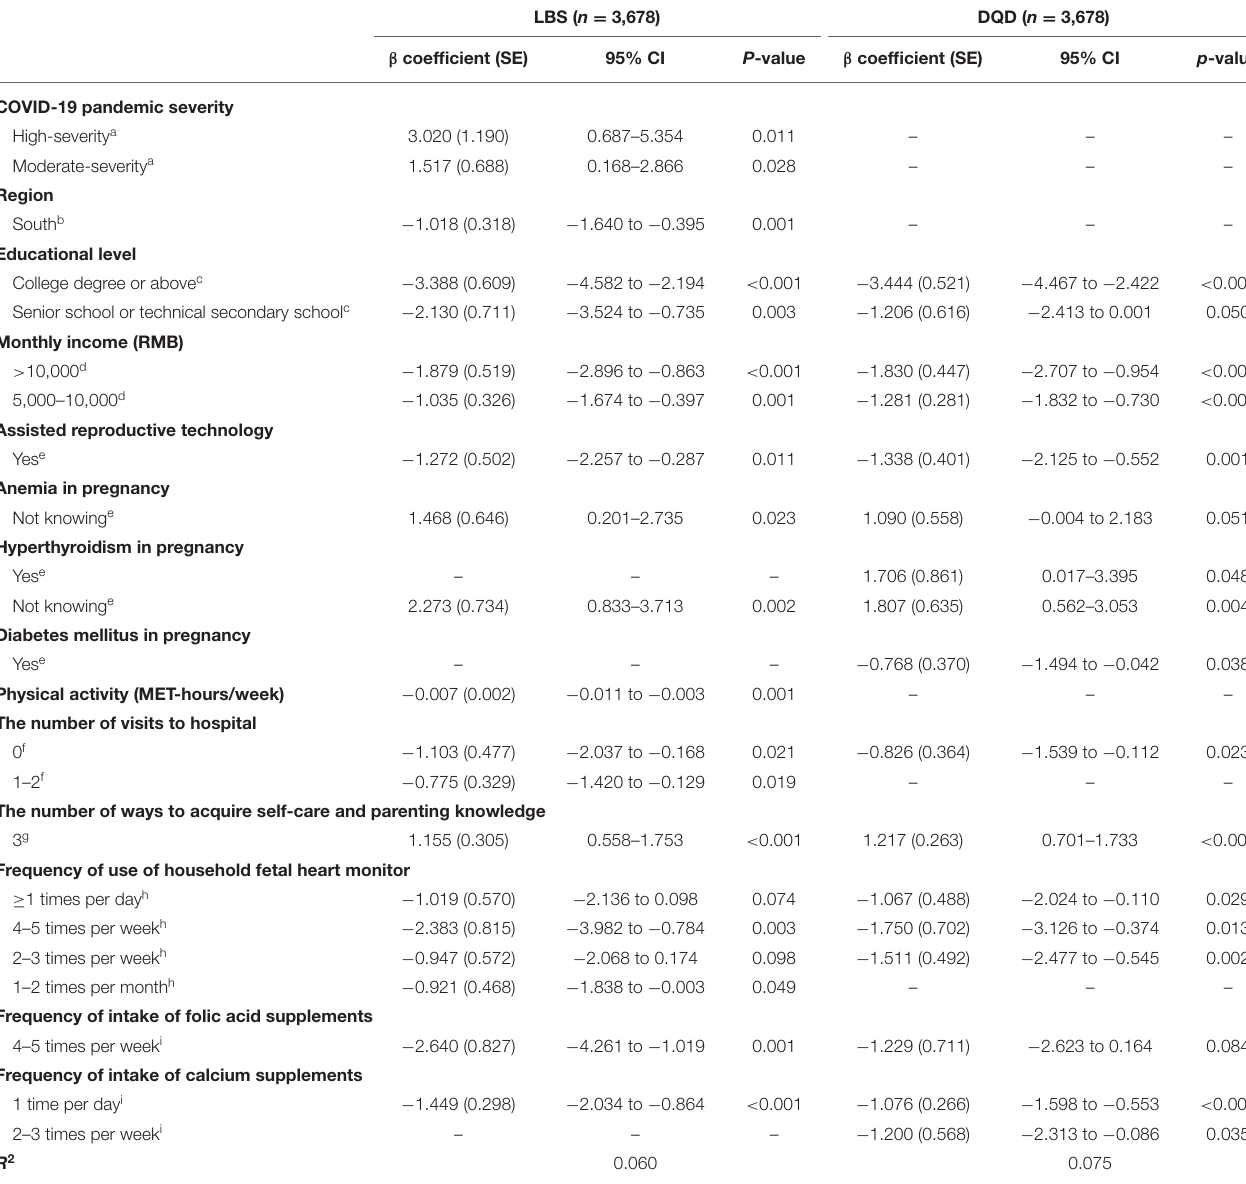
TABLE 4 | Associations of diet quality (LBS, DQD) with COVID-19 pandemic severity, demographic factors, and health-related